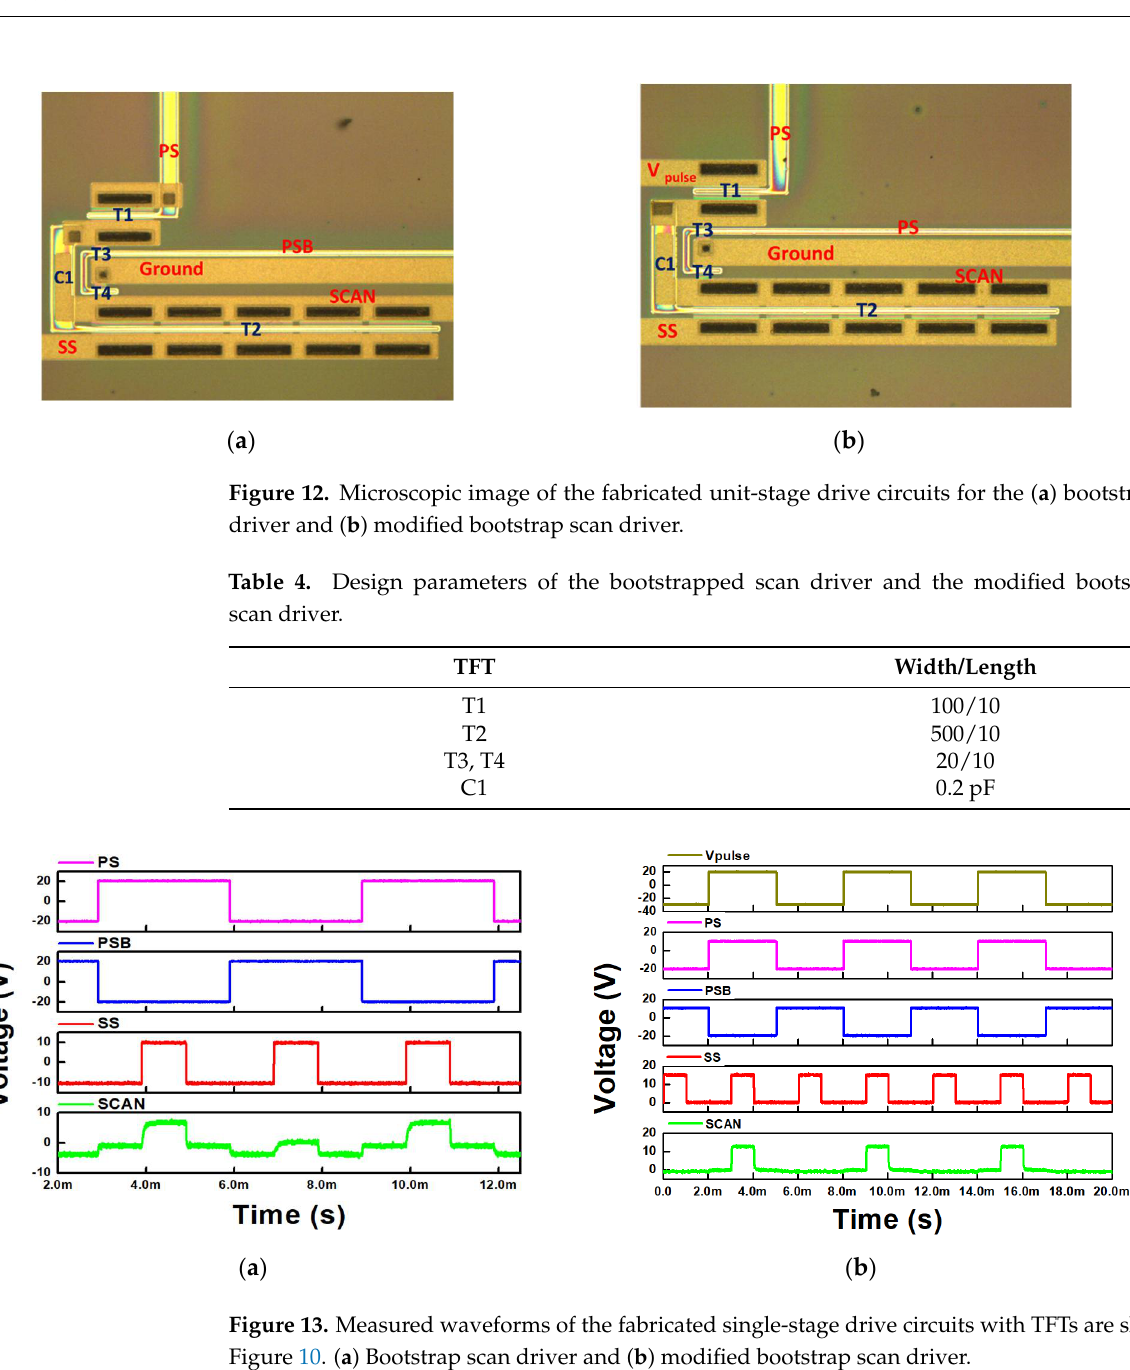
Figure 13. Measured waveforms of the fabricated single-stage drive circuits with TFTs are shown in Figure 10. ( a ) Bootstrap scan driver and ( b ) modified bootstrap scan driver.